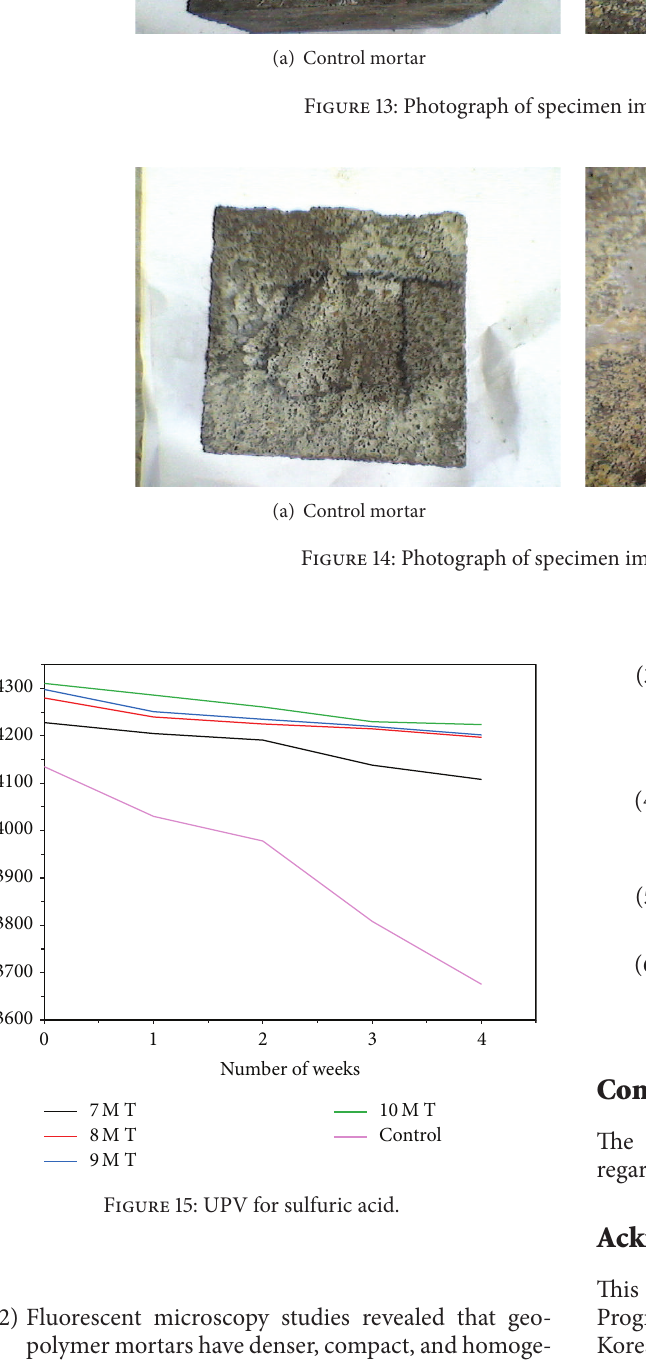
(2) Fluorescent microscopy studies revealed that geo- polymer mortars have denser, compact, and homoge- nous particle packing of the